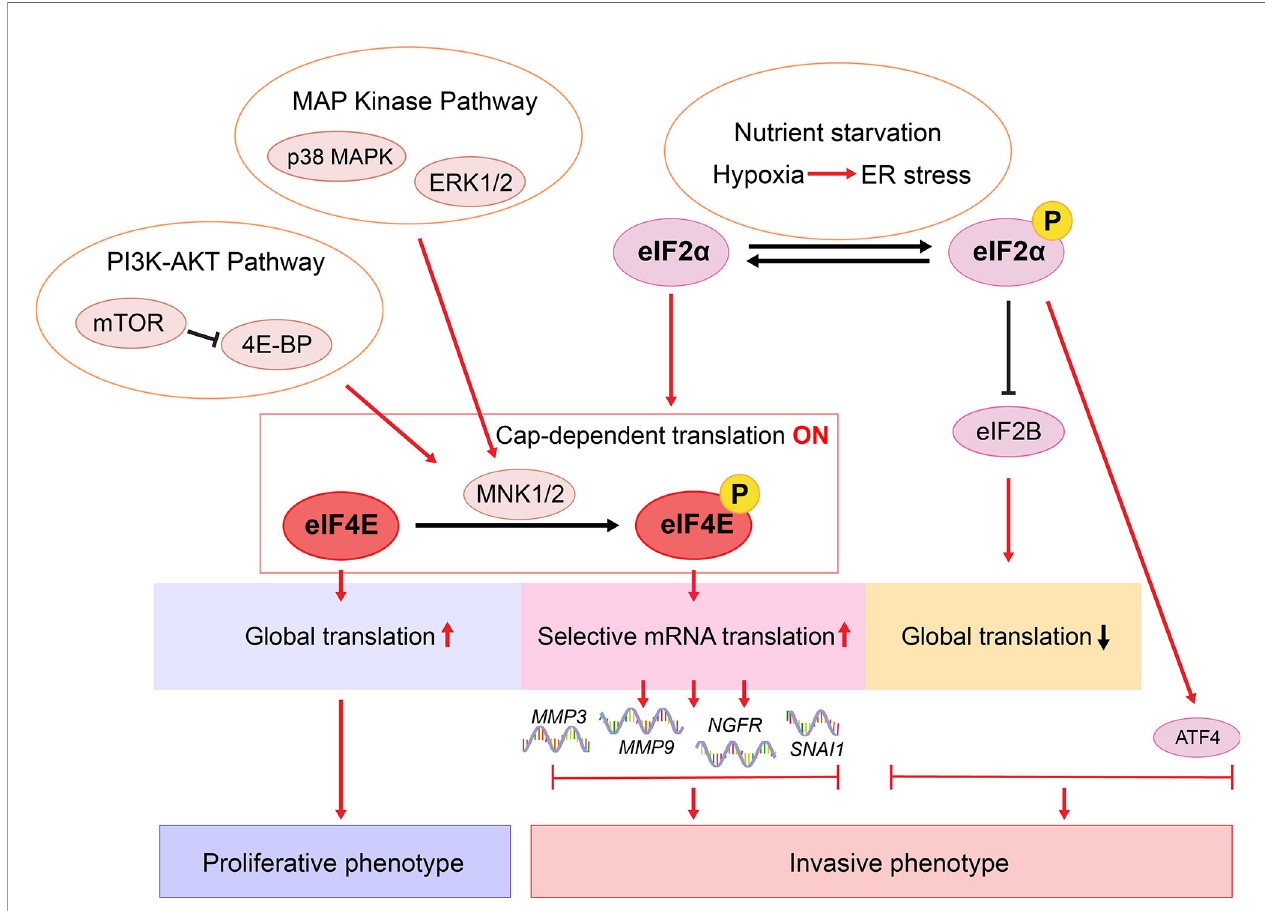
FIGURE 3 | Proposed translational regulation of melanoma phenotype switching. In response to environmental stress such as nutrient starvation, p-eIF2 a mediates ISR and inhibits eIF2B activity, which diminishes global translation whilst increasing the translation of ATF4 (9, 57, 147, 148). ATF4 cooperates with the p-eIF2 a - mediated translational reprogramming to drive phenotype switching (9, 57). In a nutrient suf fi cient environment, eIF2 a is not phosphorylated and cap-dependent translation is on. Ef fi cient global translation enables melanoma cells to sustain a proliferative state (9). Hyperactivated MAPK and PI3K-AKT pathways lead to MNK1/ 2-mediated eIF4E phosphorylation, enhancing the translation of a selected subset of mRNAs, including NGFR , MMP3 , MMP9 , and SNAI1 ( 146, 149, 150). Consequently, these oncogenes promote melanoma cell invasion, metastasis, and therapy resistance (37, 70, 146, 149, 151,